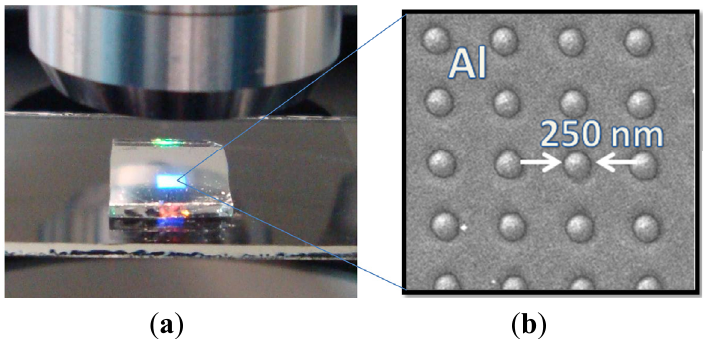
Figure 2. ( a ) A 500-nm-period Al NHA on a 1.2-mm-thick PC substrate illuminated through a microscope objective. Light diffraction is clearly observed; ( b ) SEM photograph of the nanopatterned Al surface revealing good hole diameter uniformity.